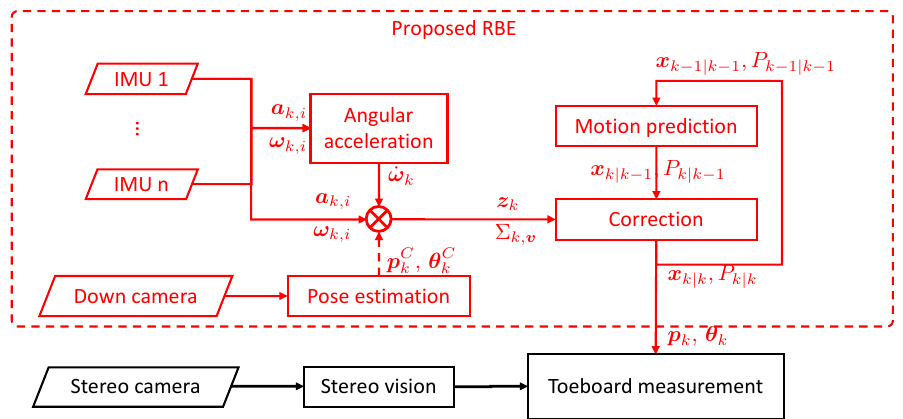
Figure 4. Proposed recursive localization of stereovision for in-crash toeboard